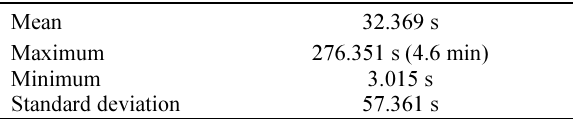
Table 6. Computation